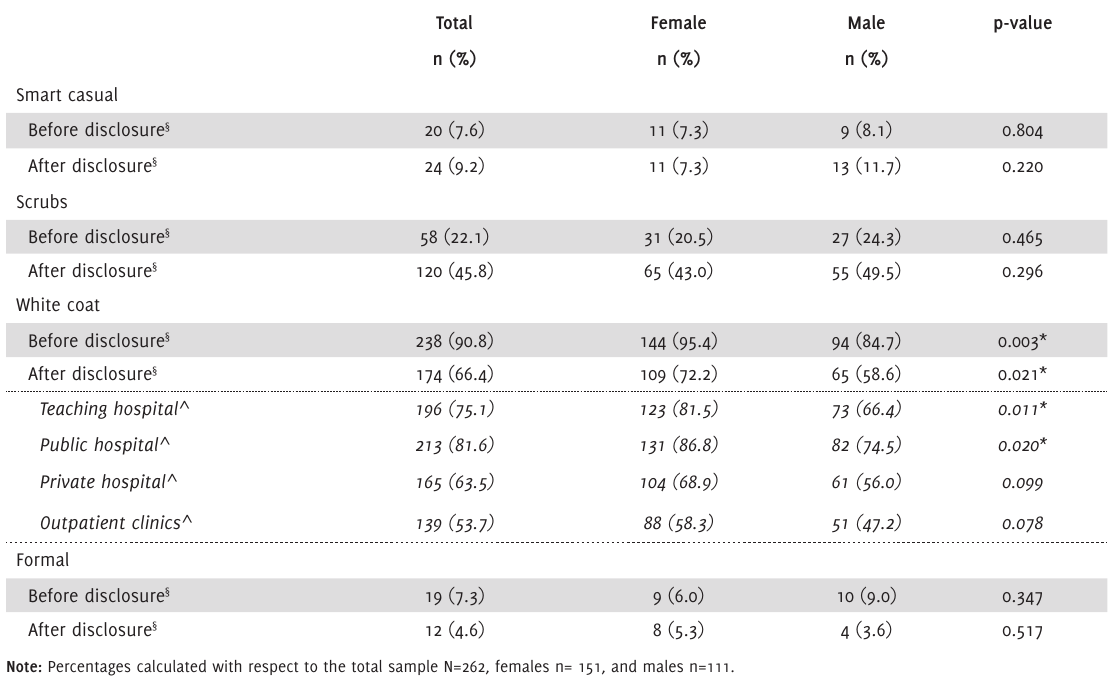
Table 3. Patients’ Acceptance on Physician’s Attire Pre- and Post-Disclosure and among Various Clinical Settings (for White Coat) by gender